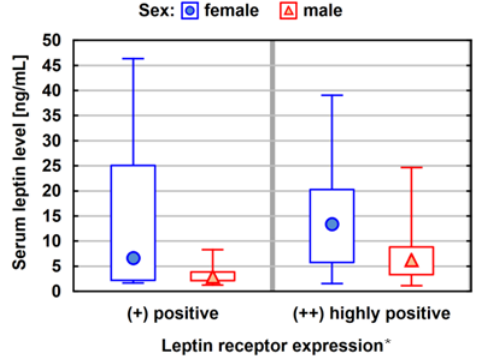
Figure 2. Median values with lower and upper quartiles and minimum and a maximum leptin con- centrations for both sexes relative to prescription leptin expression (N = 61). Statistical analysis was